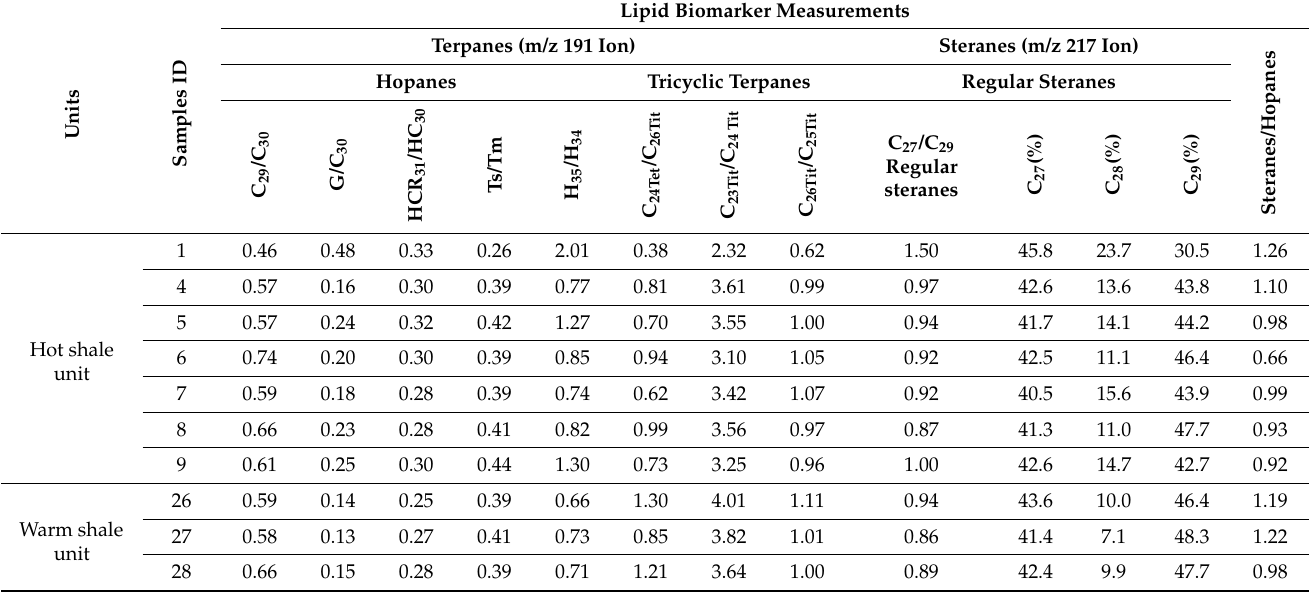
Table 2. Lipid biomarker ratios of the saturated HC fraction in the analyzed dark shales from the Silurian Qusaiba Formation in the Tayma Basin, Northwestern Saudi Arabia, illustrating source organic matter and depositional environment